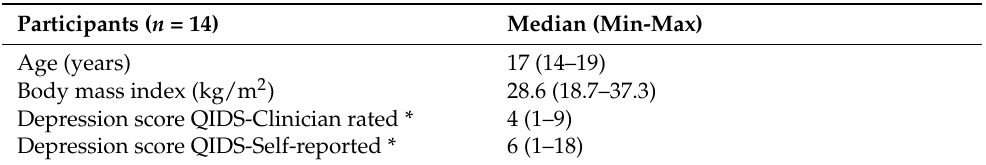
Table 1. Participant characteristics at the one-year